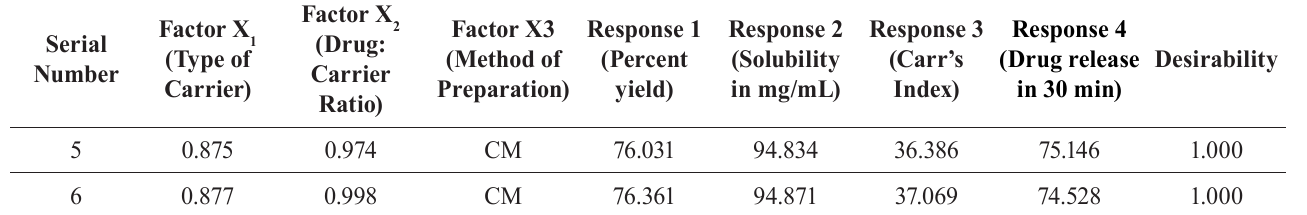
TABLE IV - List of optimum solutions suggested by the I-optimal design by numerical optimization technique